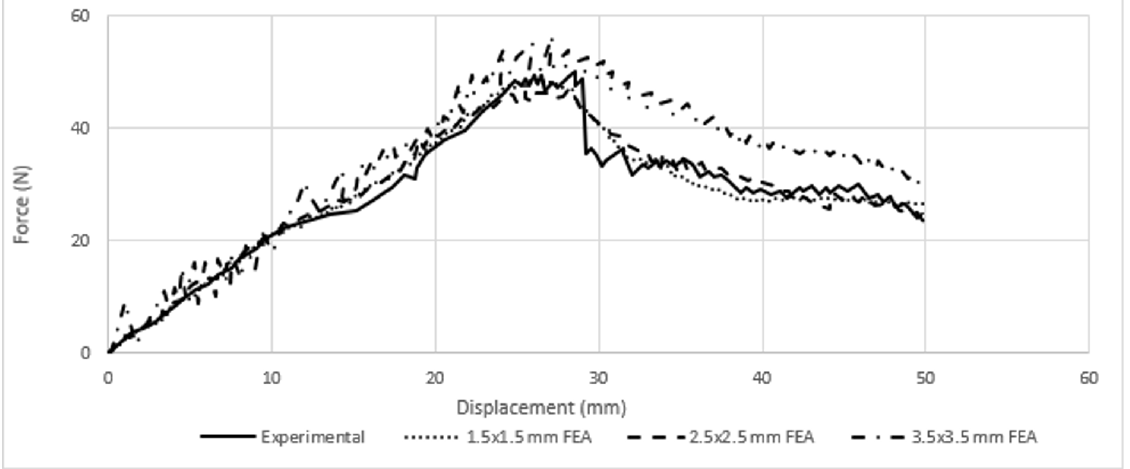
Figure 18. Force – distance curve of Mode-I delamination, experimental and FEA comparison [66]. Figure 18. Force–distance curve of Mode-I delamination, experimental and FEA comparison